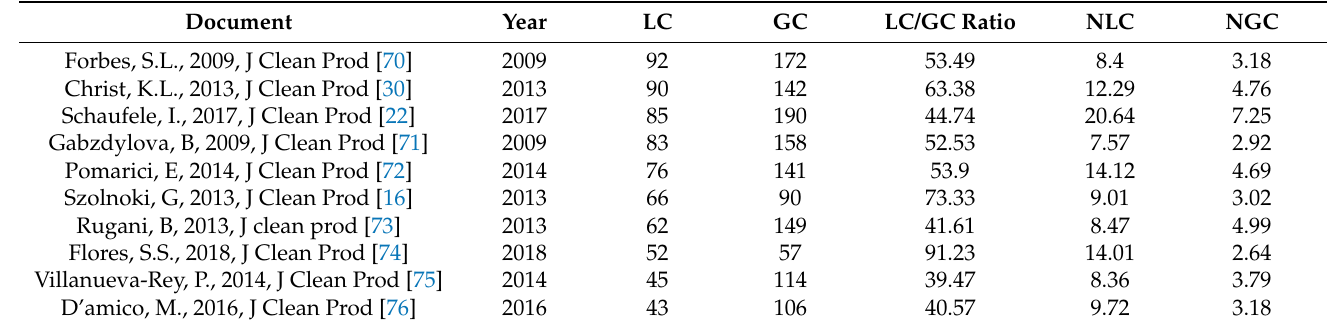
Table 6. Ranking of the most relevant articles by local and global citations.